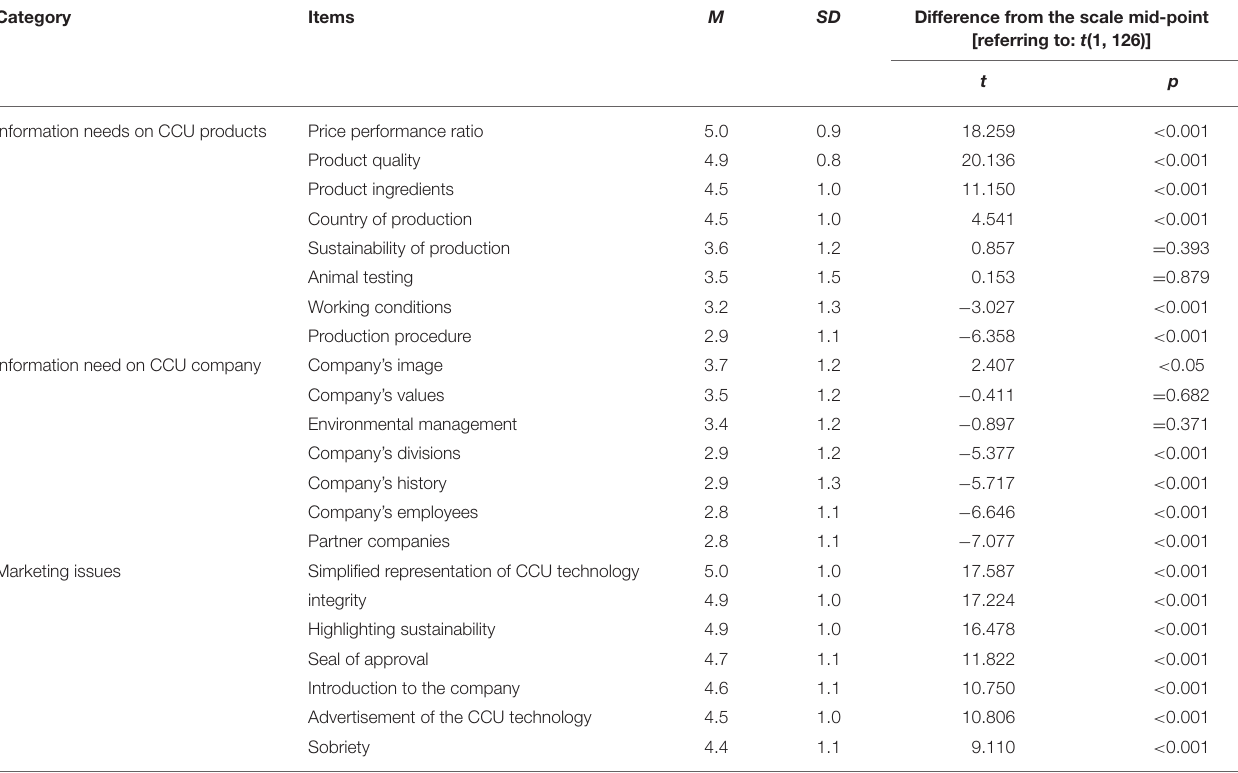
[referring to: t (1, 126)] t p